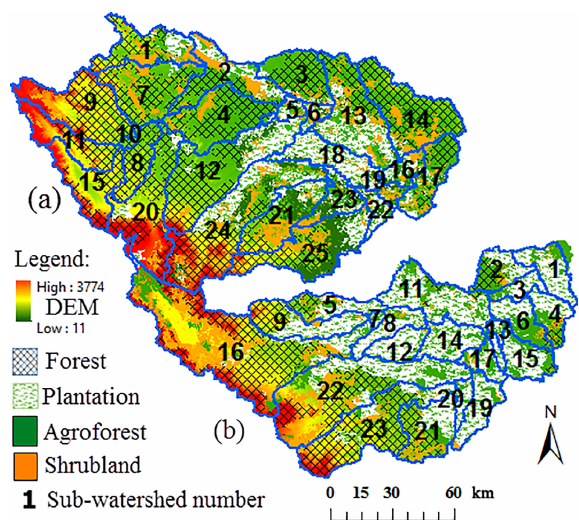
Figure 3. Land use types and sub-watershed number of the (a) BH and (b) MT